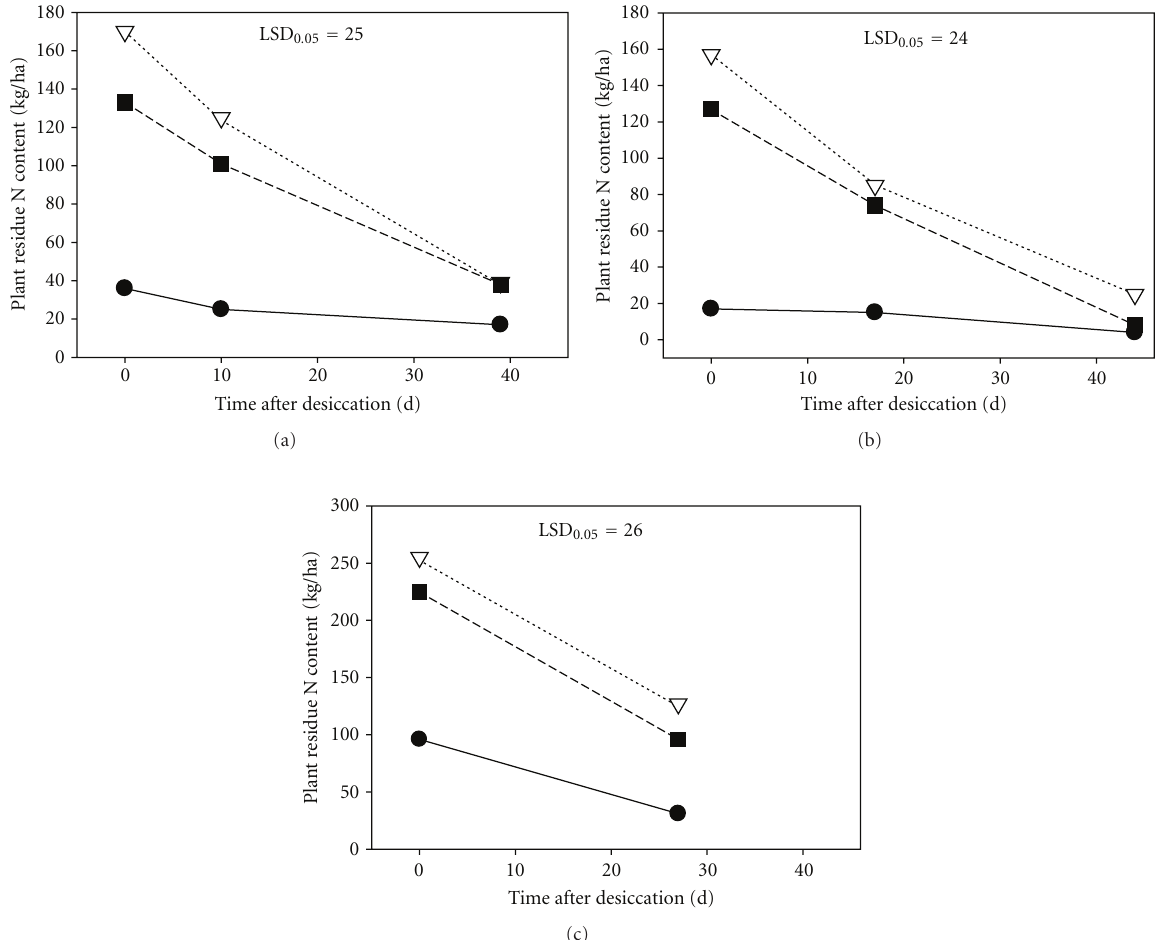
Figure 1: Nitrogen content of plant residues as a ff ected by cover crop, circles no cover crop, triangles Austrian winter pea, squares hairy vetch, (a) = 2005, (b) = 2006, and (c) =